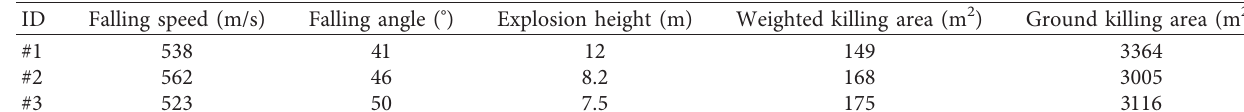
Table 3: Warhead explosion attitude and killing